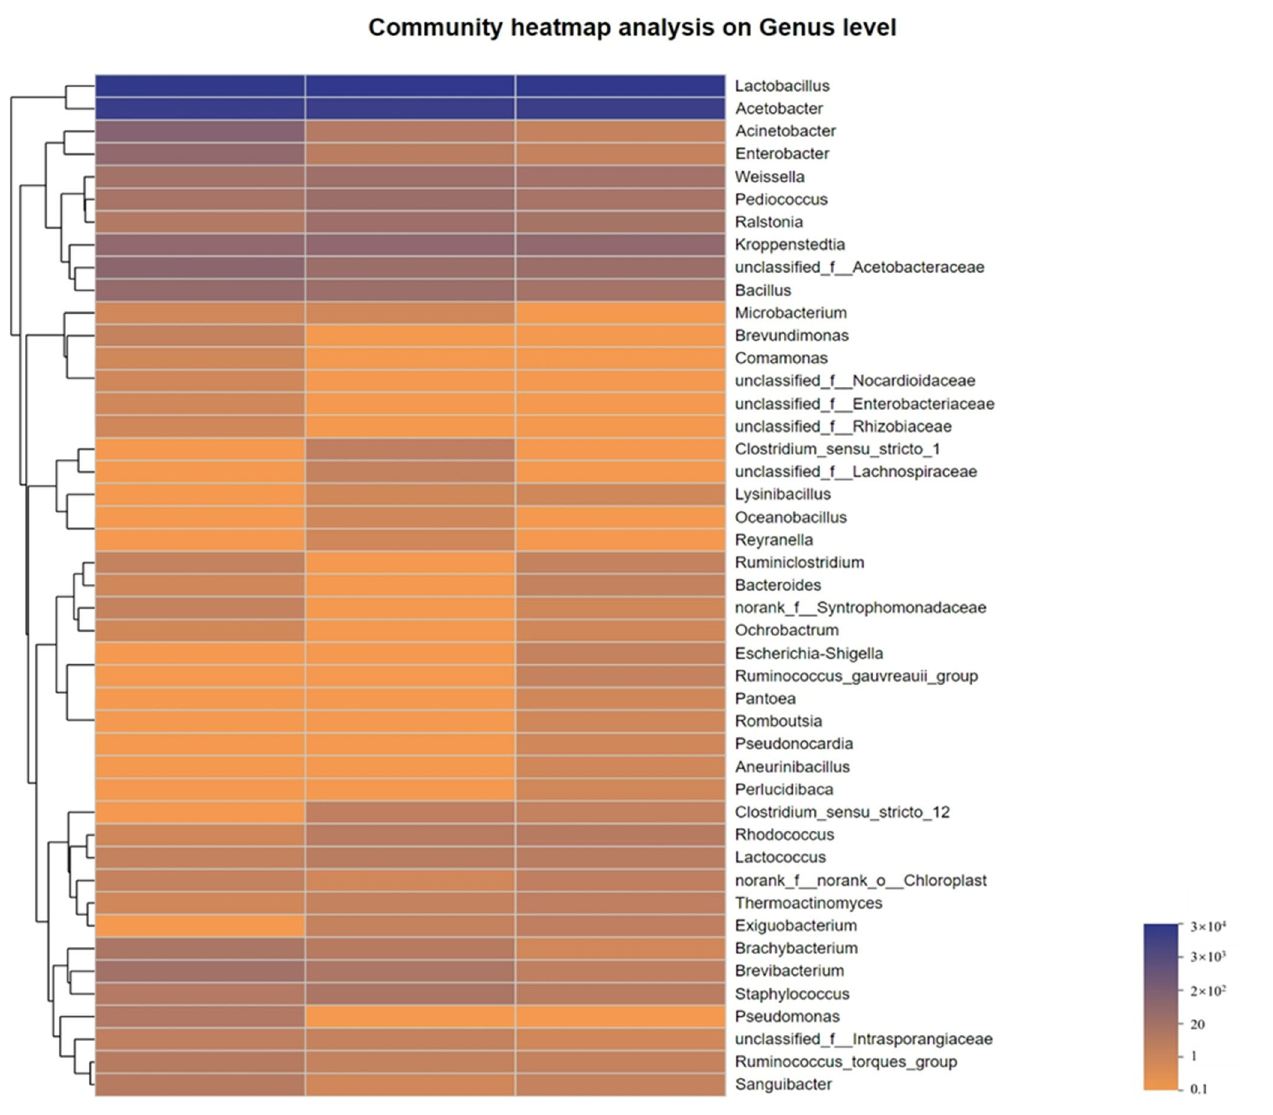
Figure 3. Heat map of horizontal communities of bacteria in fermented grain samples. Note: the color gradient of the color patch represents the change in abundance of different species in the sample, with the species cluster tree on the left and the value represented by the color gradient on the right.